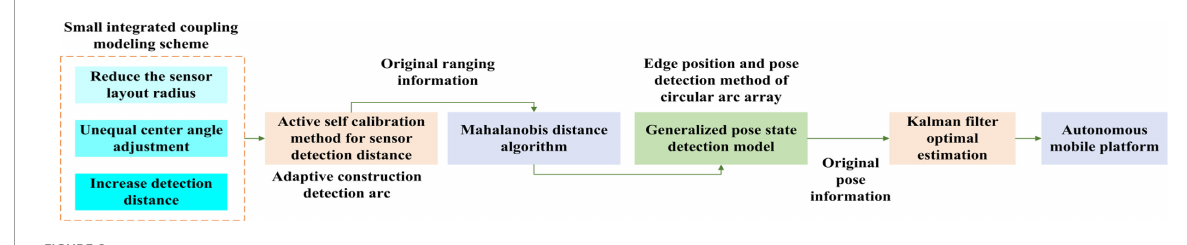
FIGURE6 An overall architecture of a small integrated arc array edge navigation sensor module.